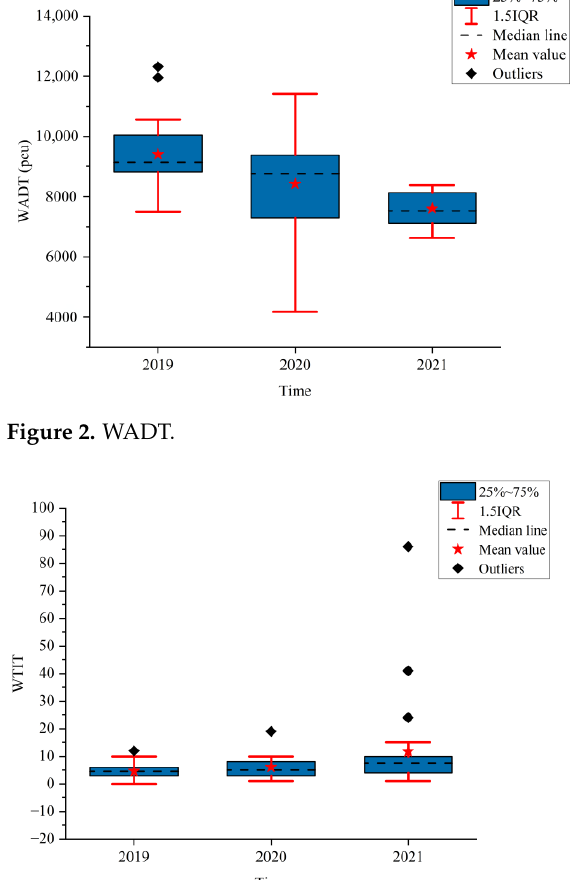
Figure 3. Figure 3. WTIT.